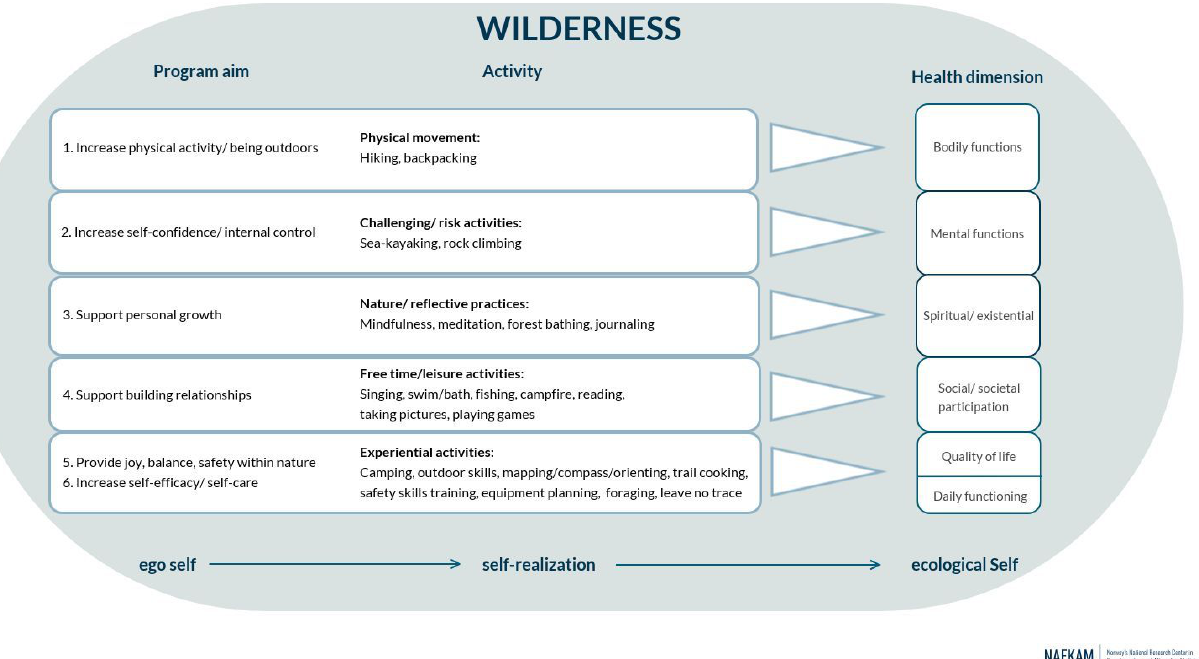
Figure 1. Schematic overview of the WAYA